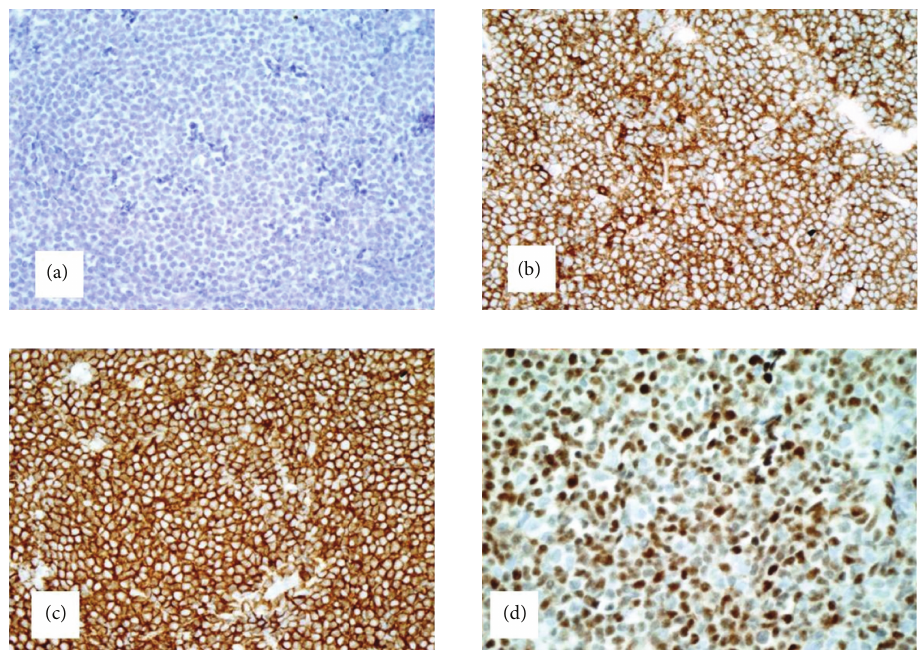
Figure 4: (a) Neoplastic lymphoid cells showing a lack of immunoreactivity for AE1/AE3, which assists in ruling out carcinoma (AE1/AE3; 100x magnification). (b) and (c) CD5 and CD20, respectively, demonstrate that the cell lineage for the neoplastic lymphocytes is the B lymphocyte with aberrant coimmunoreactivity with CD5. (CD5; CD20; 100x magnification). (d) Cyclin D1 staining positivity in theneoplastic cells is strongly associated with mantle cell lymphoma (Cyclin D1; 100x